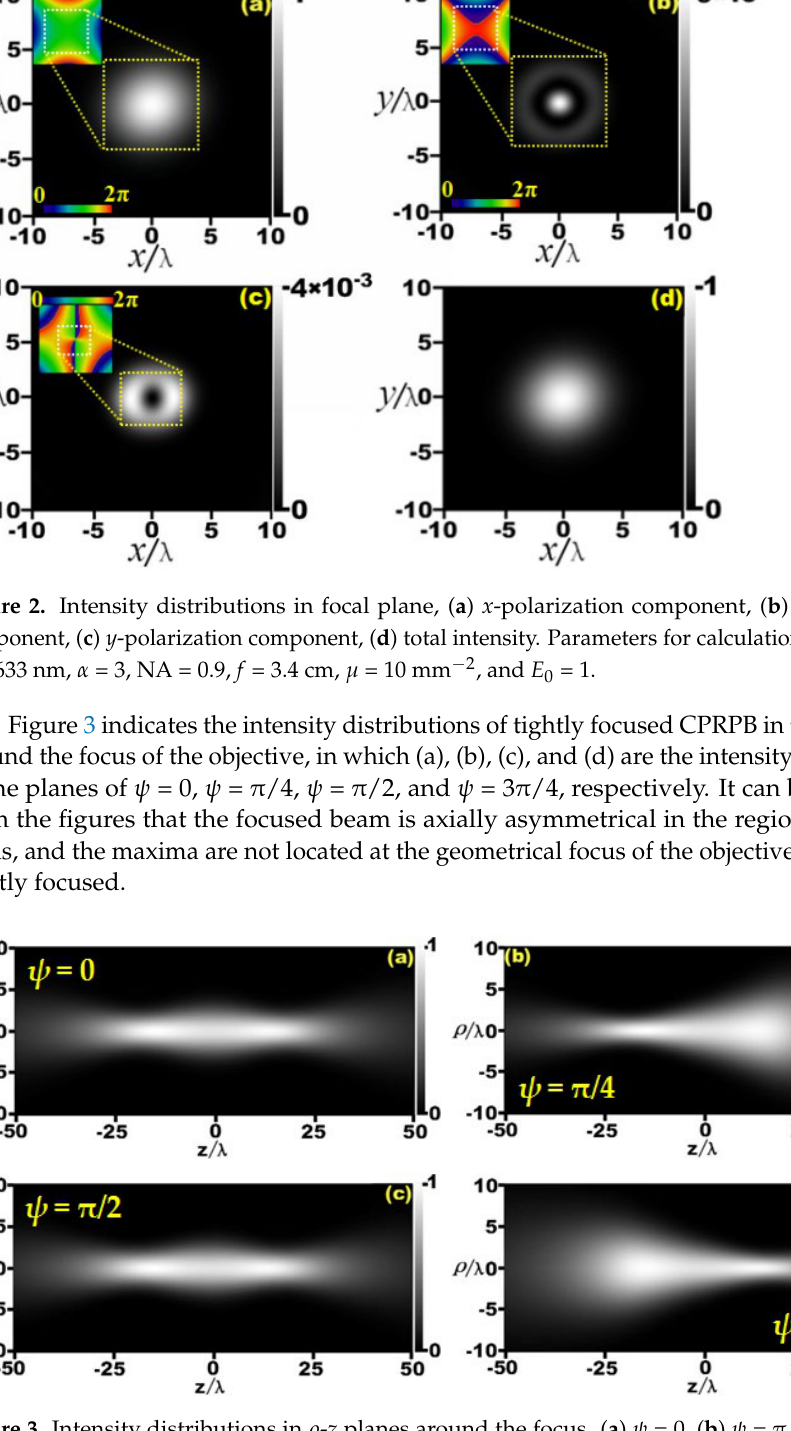
Figure 3. Intensity distributions in ρ - z planes around the focus. ( a ) ψ = 0, ( b ) ψ = π /4, ( c ) ψ = π /2, and ( d ) ψ = 3 π /4. Parameters for calculation are chosen as λ = 633 nm, α = 3, NA = 0.9, f = 3.4 cm, μ = 10 mm ₋ 2 , and E 0 = 1.